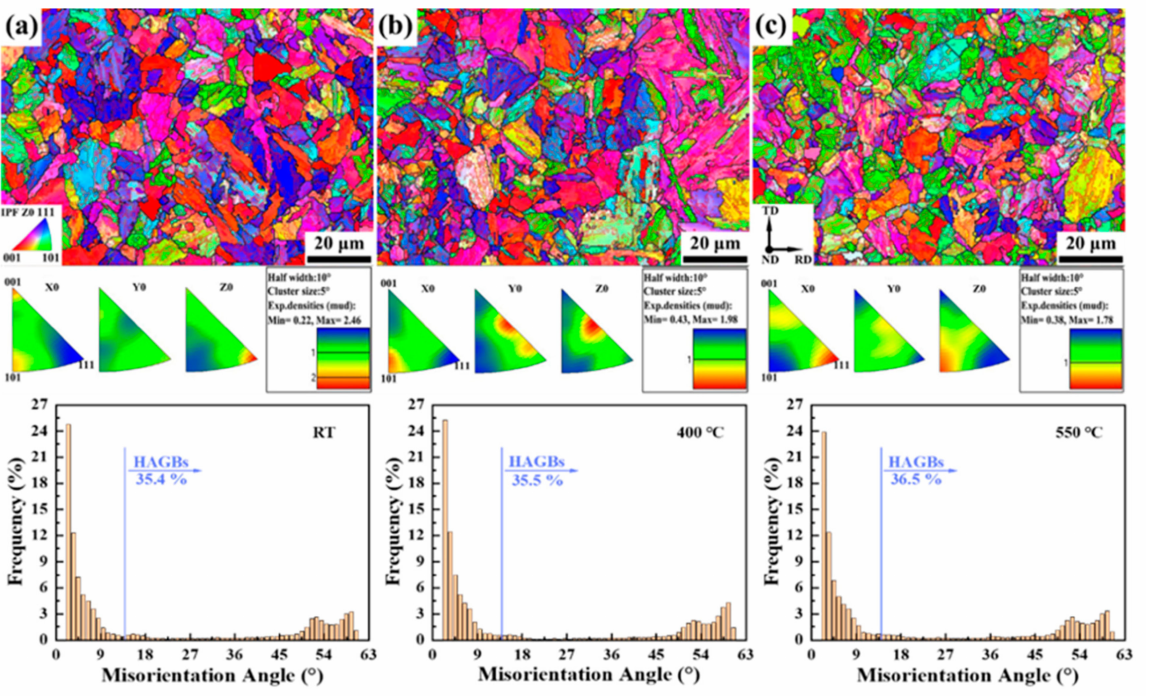
Figure 5. IPFs of plane B at ( a ) RT, ( b ) 400 ◦ C, and ( c ) 550 ◦ C of 9Cr-F/M steel and the histogram of misorientation angle of Z0 direction corresponding to each